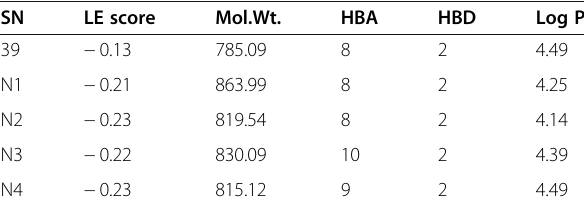
Table 4 Ligand efficiency score and drug-likeness properties based on Lipinski ’ s